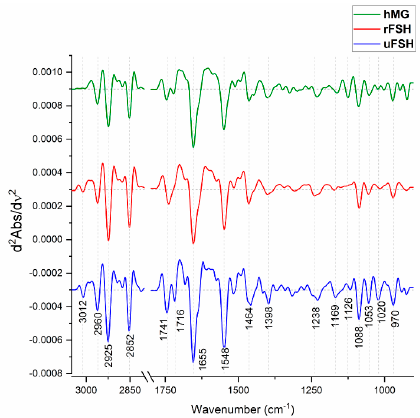
Figure 5. Analysis of spectral profiles. Average spectra of uFSH, rFSH and hMG experimental groups, reported in second derivative mode (3050–900 cm − 1 ). The wavenumbers of the most relevant peaks are shown at the bottom.